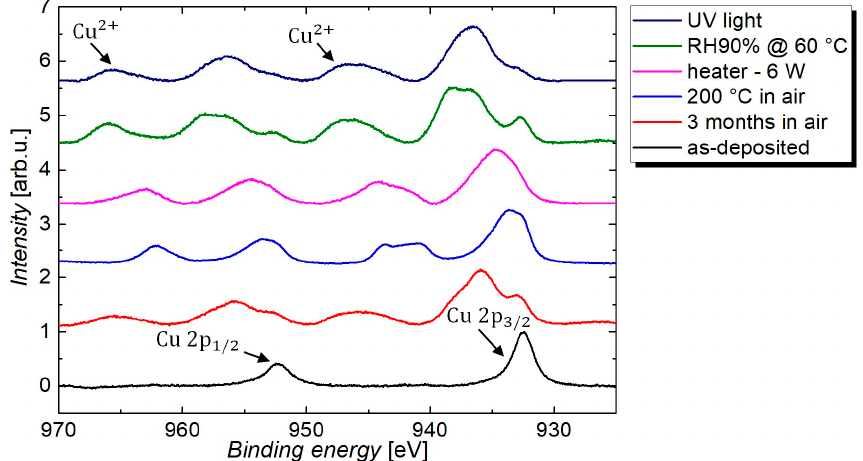
Figure 11. X-ray photoelectron spectroscopy (XPS) spectra for CuNW film that were subjected to different environmental stresses, under ambient air, i.e., (1) as-deposited, (2) exposure to ambient air for 3 months, (3) subjected to a temperature of 200 °C for a duration of 30 min, (4) heated at a power of 6 W until breakdown, (5) subjected to a relative humidity of 90%RH, at a temperature of 60 °C, and (6) UV-light exposure.